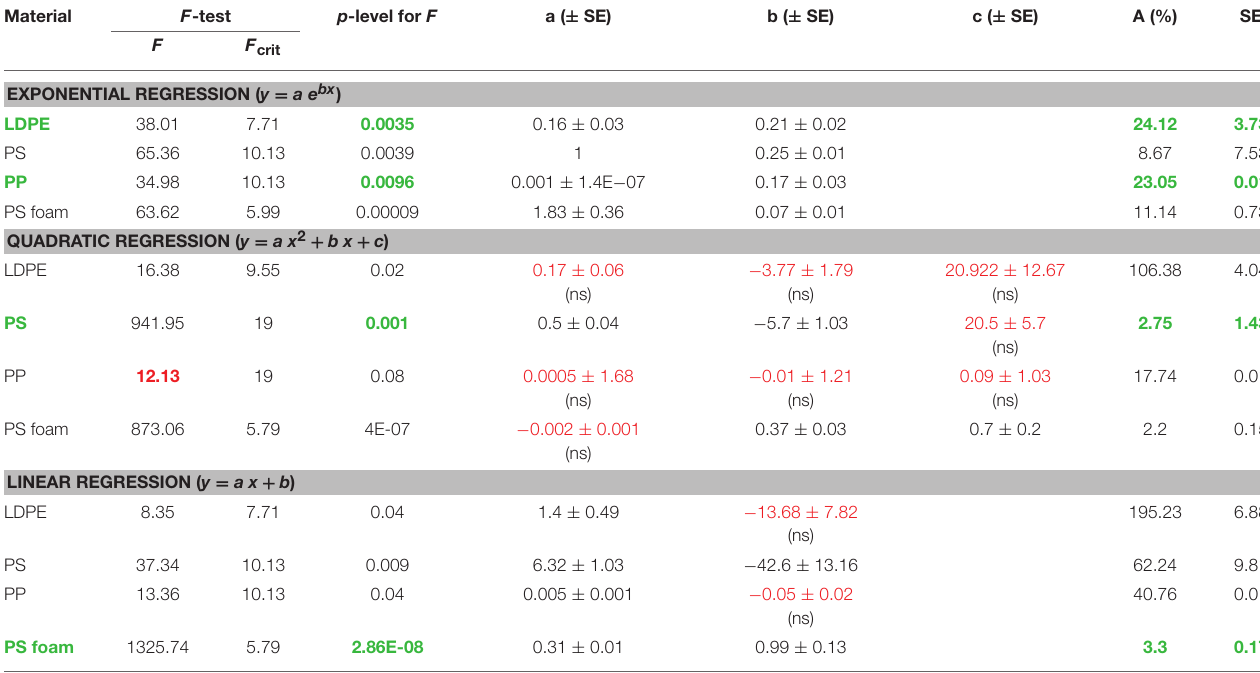
TABLE 1 | Results of statistical analysis of exponential, quadratic, and linear models for relationship between the mass of microplastics and time of degradation of large plastic items in laboratory mixer.